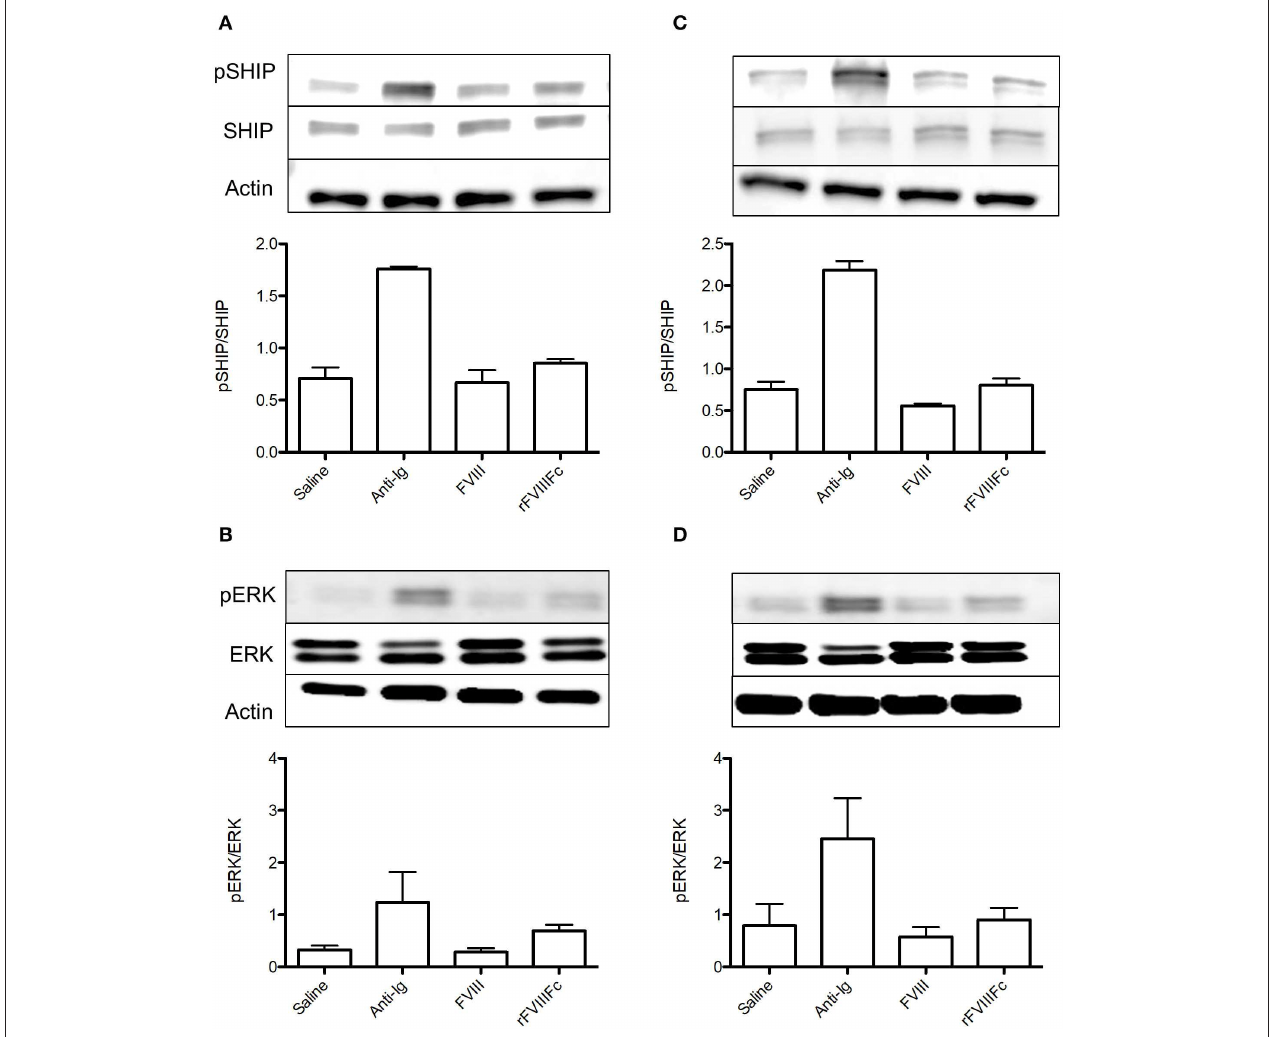
FIGURE 3 | rFVIIIFc affects signaling in both naïve and FVIII-exposed whole splenocytes. pSHIP and pERK levels in saline, anti-Ig (20 µ g/ml), FVIII (11.4 µ g/ml), and rFVIIIFc (14.7 µ g/ml) stimulated (A,B) naïve and (C,D) FVIII-exposed splenocytes. Ratios of phosphorylated to total protein were obtained through densitometry analysis of three different blots. n = 3/condition. Error bars represent